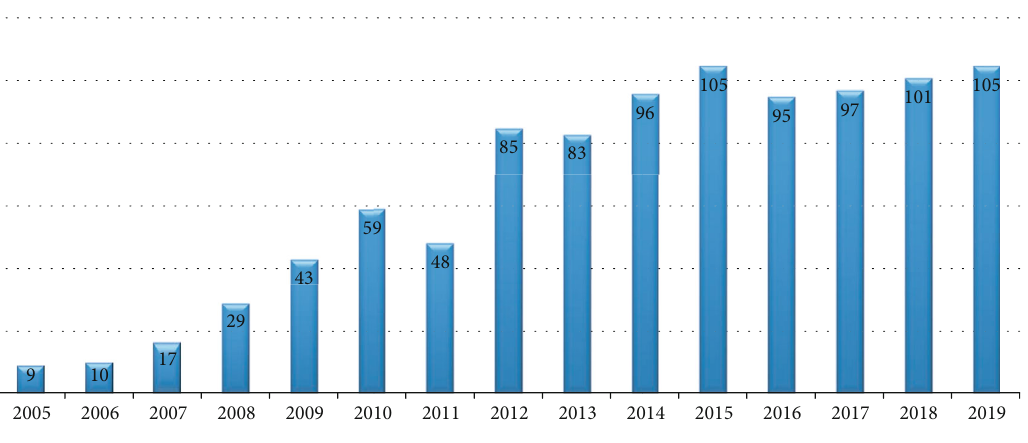
Figure 3: The trend of MSC-based clinical trials within the past 15 years. Each bar represents the total number of registered trials within the year. This indicates an increasing interest in this area with the highest annual registered clinical trials reaching 105 in the years 2015 and 2019, followed by 101 in